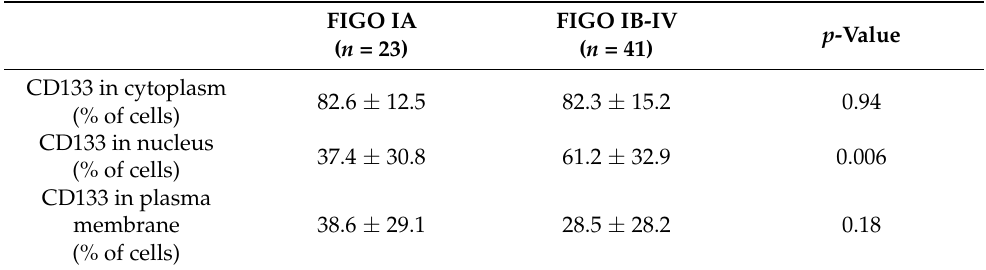
Table 3. Nuclear localization of CD133 is increased in FIGO IB-IV stages compared to FIGO IA. FIGO IA